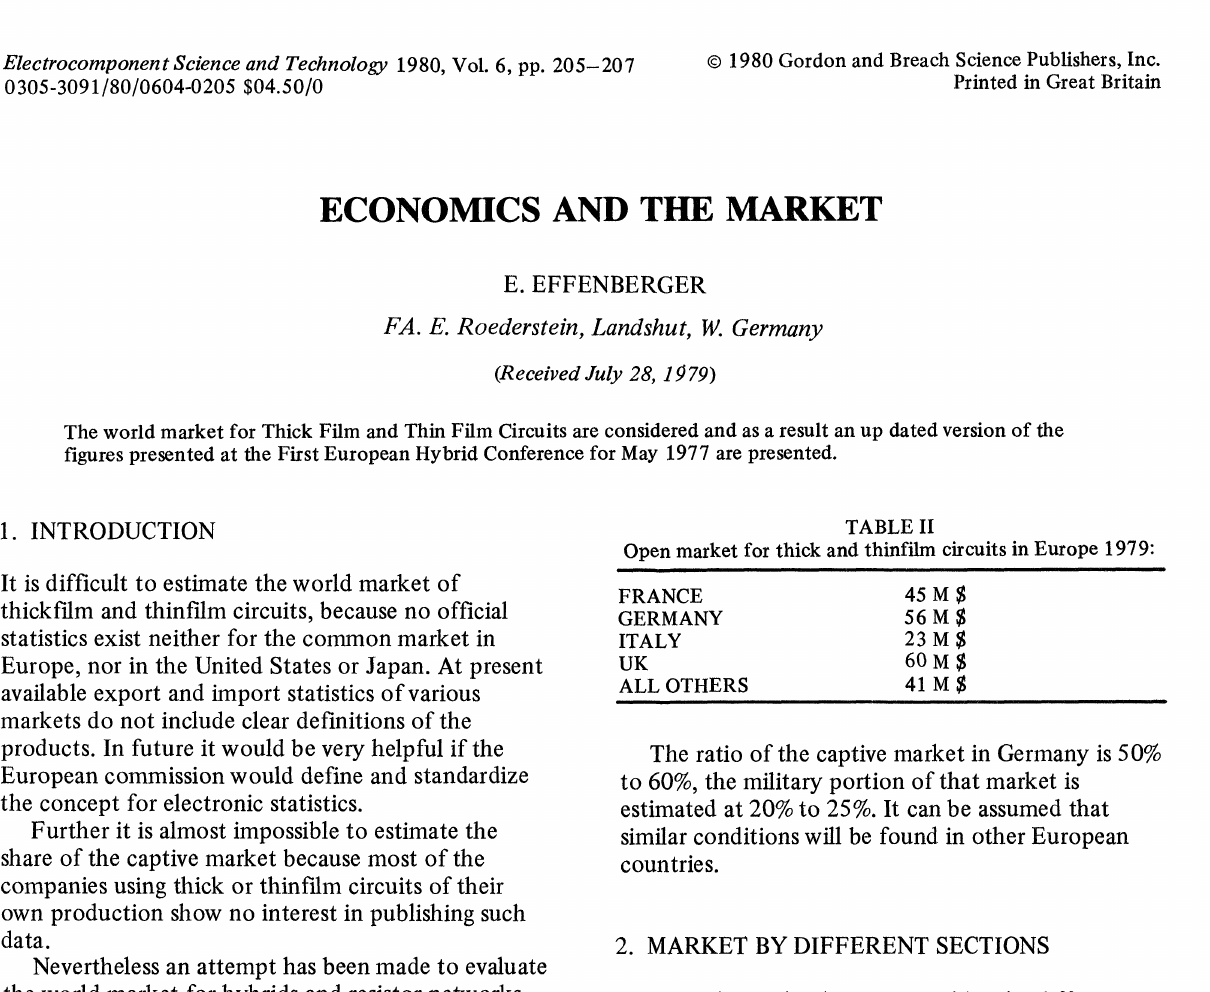
shows the shares covered by the different